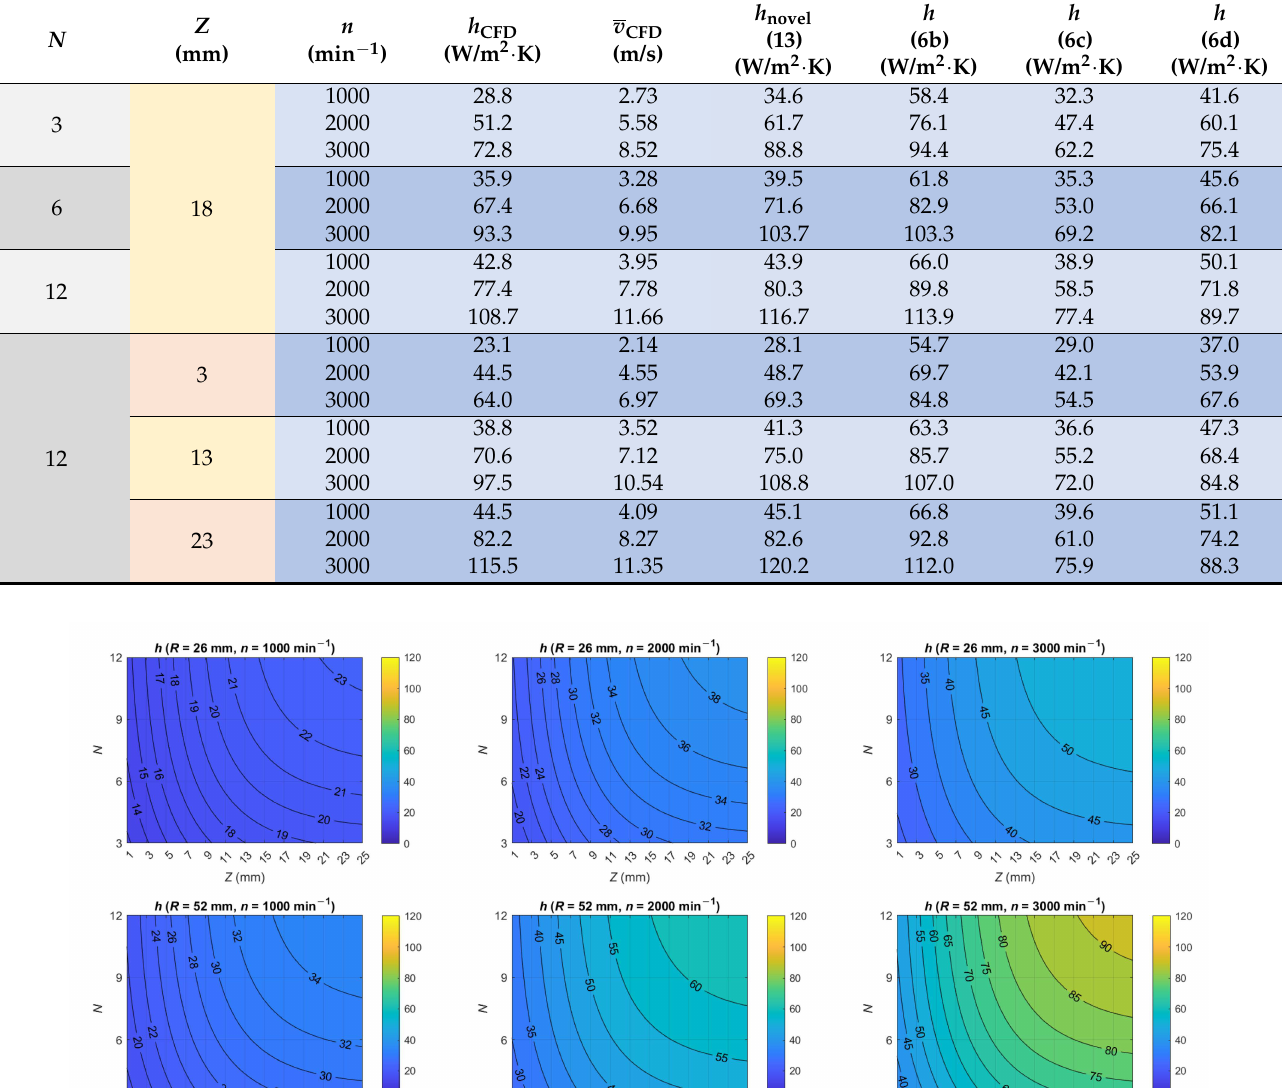
Table 9. Comparison between novel approach and reference equations for calculating HTC compared to CFD simulation results ( R = 78 mm).